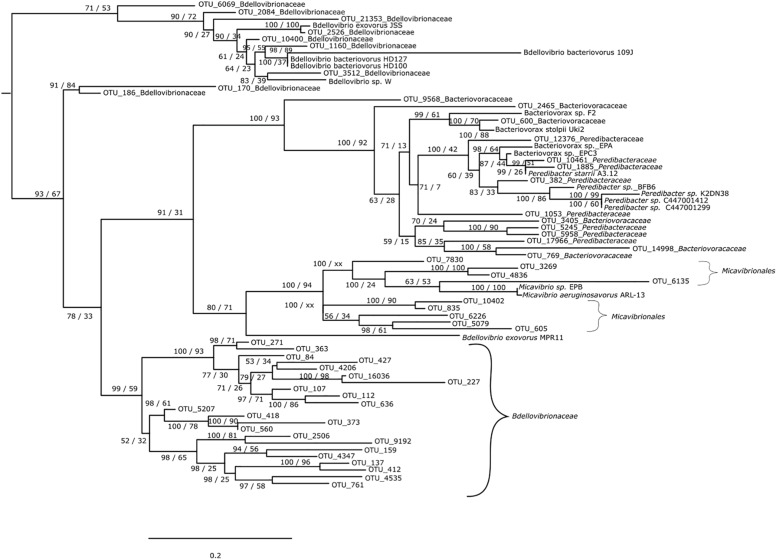
Phylogenetic tree of BALOs environmental sequences with reference database sequence. The tree is based on maximum likelihood analysis and Bayesian inference. Posterior probability (PP) values followed by bootstrap values are added to the left of a node when possible (PP/BS). Vampirovibrio chlorellavorus (not shown) was used as an outgroup to root the tree.